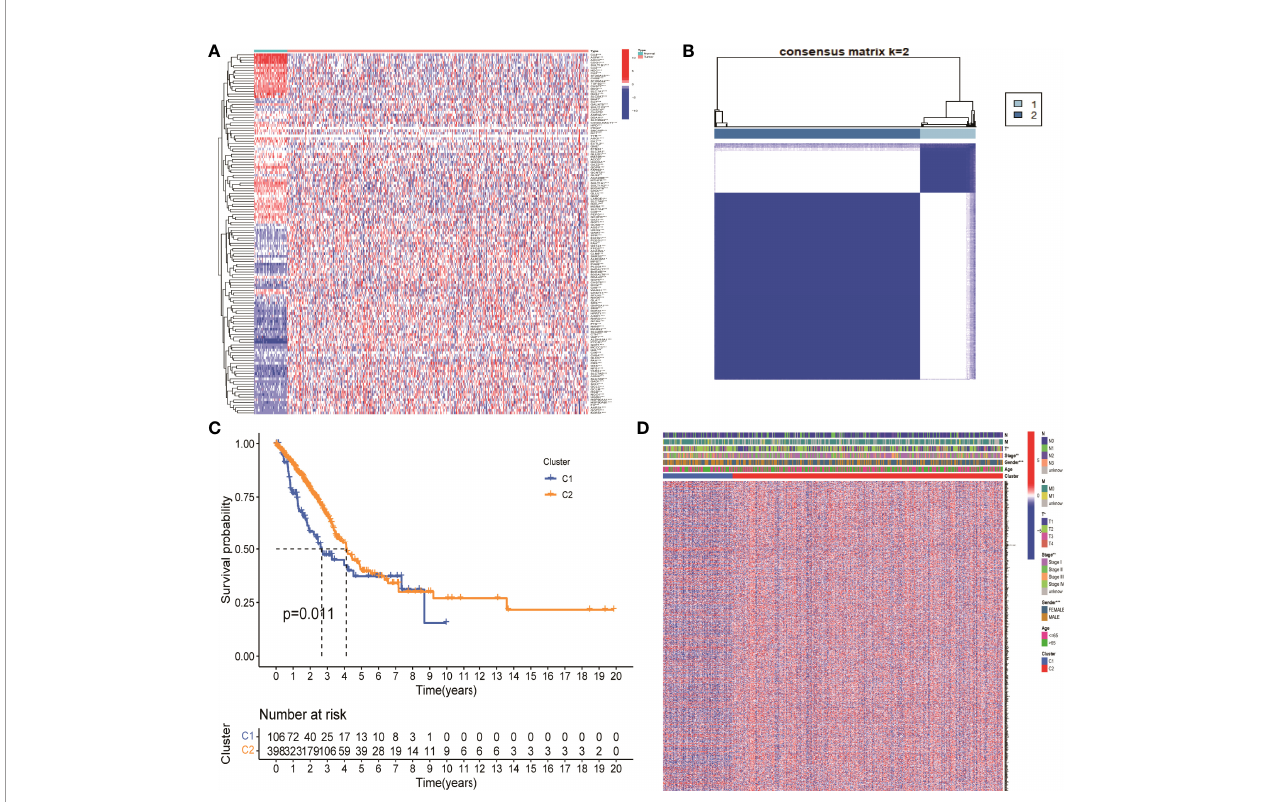
FIGURE 1 | Identi fi cation of differentially expressed genes associated with nitrogen metabolism in lung adenocarcinoma. (A) Differential expression analysis identi fi ed 138 genes related to nitrogen metabolism in lung adenocarcinoma. (B) Consistent cluster analysis divided 138 genes into two gene modules. (C) KM survival analysis showed signi fi cant differences between C1 and C2 gene modules. (D) Clinical factors such as sex, clinical stage, and T stage showed signi fi cant differences between the two gene